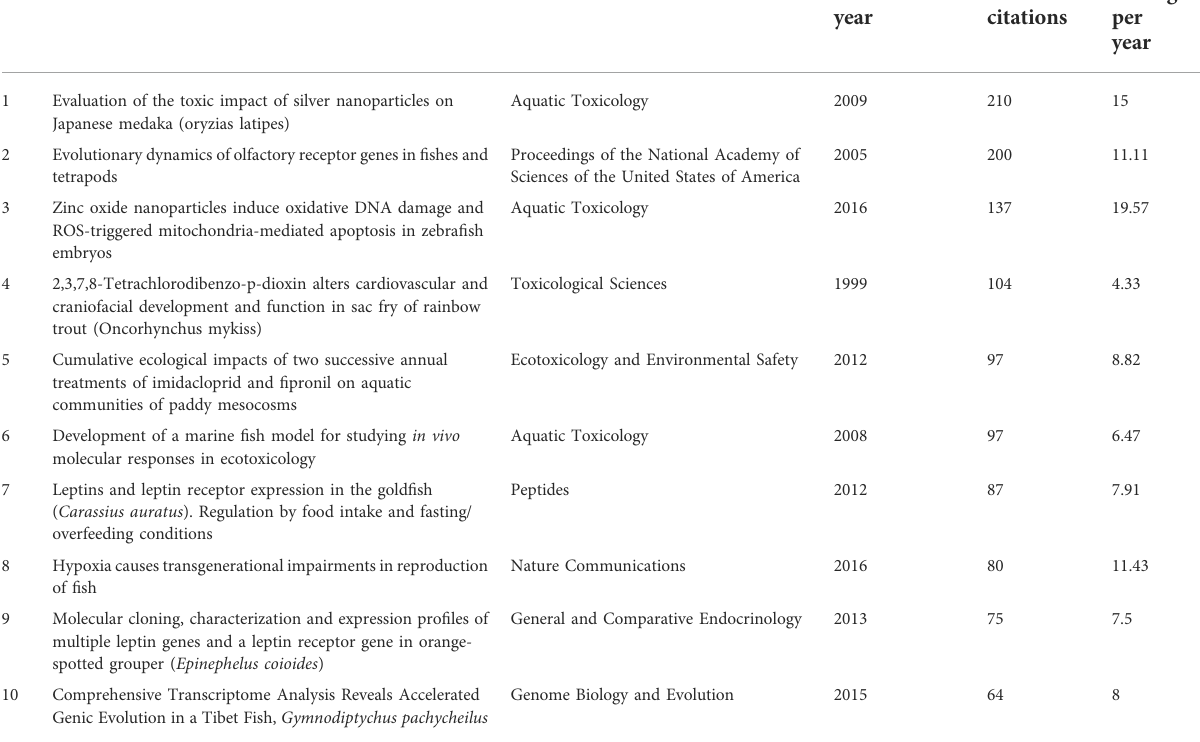
TABLE 1 The articles with the highest citations for research on medaka and climate